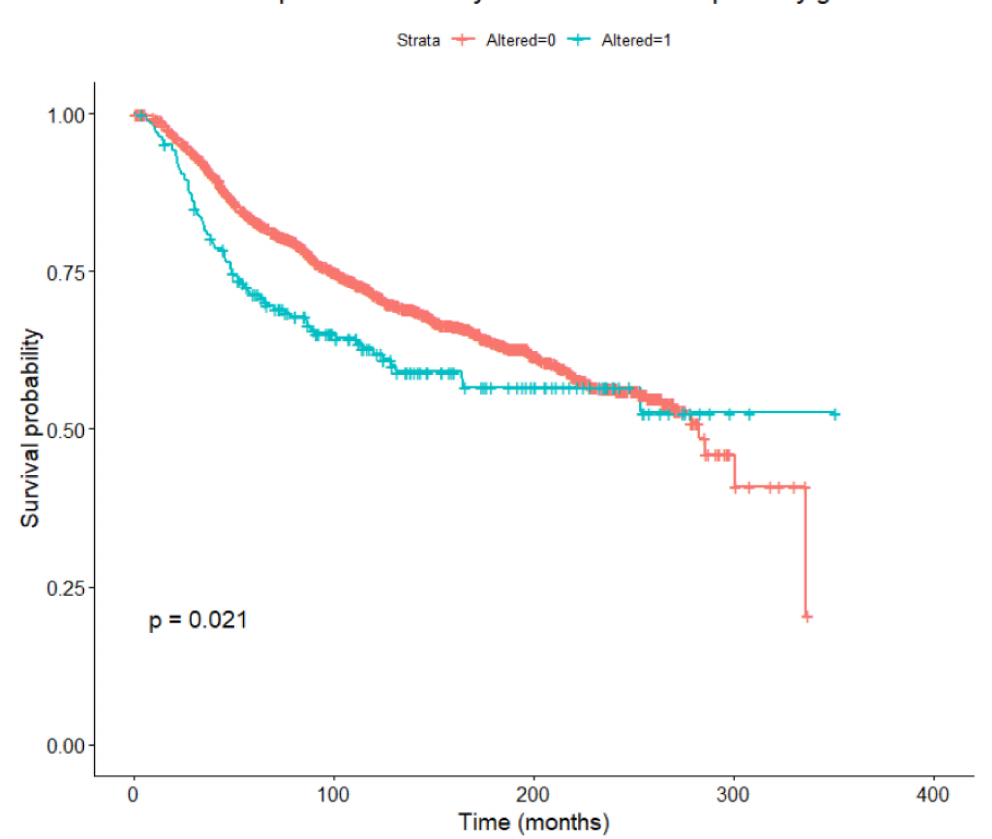
Figure 5. Breast-cancer-specific survival according to the presence or absence of any alteration in RAS/RAF/MEK/ERK pathway genes (log-rank